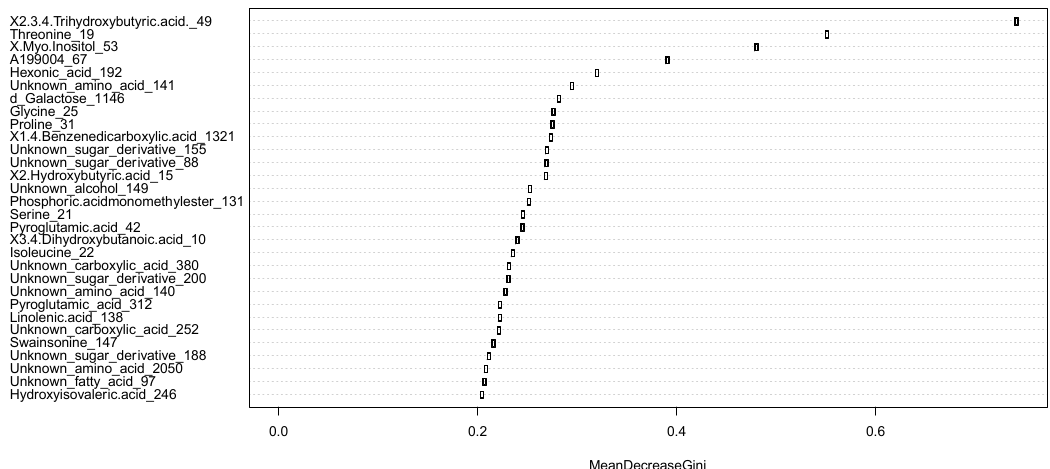
Figure 4. The metabolites that correlate the most to the MRI findings according to mean decrease of Gini index according to the random forest model. Table 3. Relative levels of the important metabolites within the two MRI findings groups. SD, standard deviation.